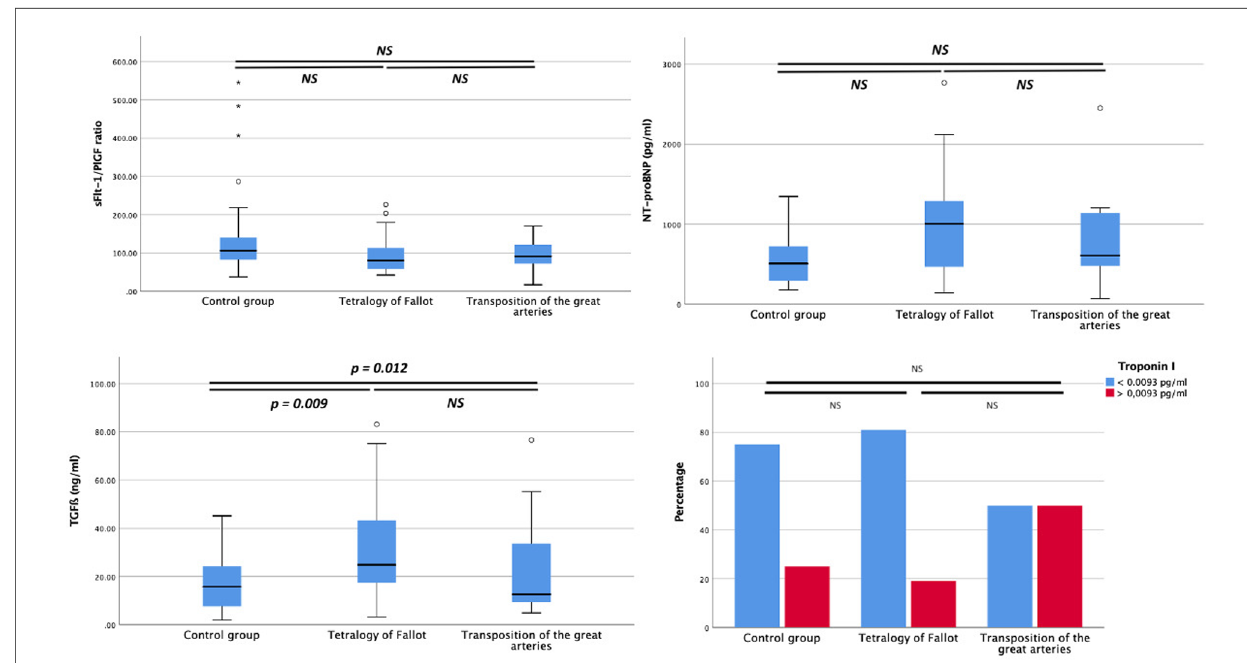
FIGURE 2 Umbilical cord concentrations of tyrosine kinase-1/placental growth factor (sFlt-1/PlGF) ratio, N-terminal precursor of B-type natriuretic peptide, transforming growth factor ß (TGFß) and percentage of fetuses with troponin I positive (considered positive if concentration >0.0093 pg/ml which represents 75th centile in the control population), in fetuses with tetralogy of fallot, transposition of the great arteries and in normal fetuses. P< 0.05 is considered statistically signi fi cant. NS: not signi fi